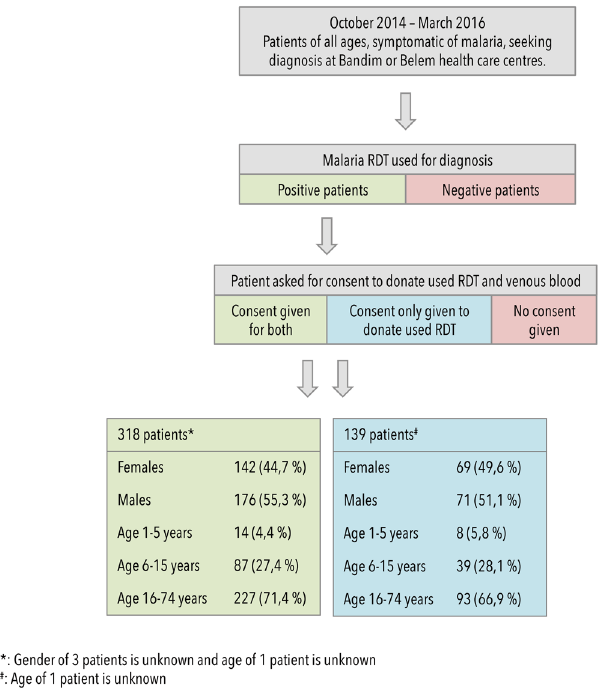
Figure 1. Patient recruitment and demography. Patients of all ages attending the Bandim or Belem health care centres, with a fever or a history of fever within the past 24 hours, were tested for malaria positivity with an RDT. If the patient tested positive, the patient was asked for informed consent in donating the RDT used to test them for malaria infection. The malaria-positive patients were furthermore asked for informed consent in donating venous blood. If consent was given for this procedure, the blood was drawn and the patient was included in the study. In total, 457 malaria-positive patients gave consent to donate their RDTs and 318 of these patients gave consent to donate venous blood. If venous blood was donated, the RDT was not used for the